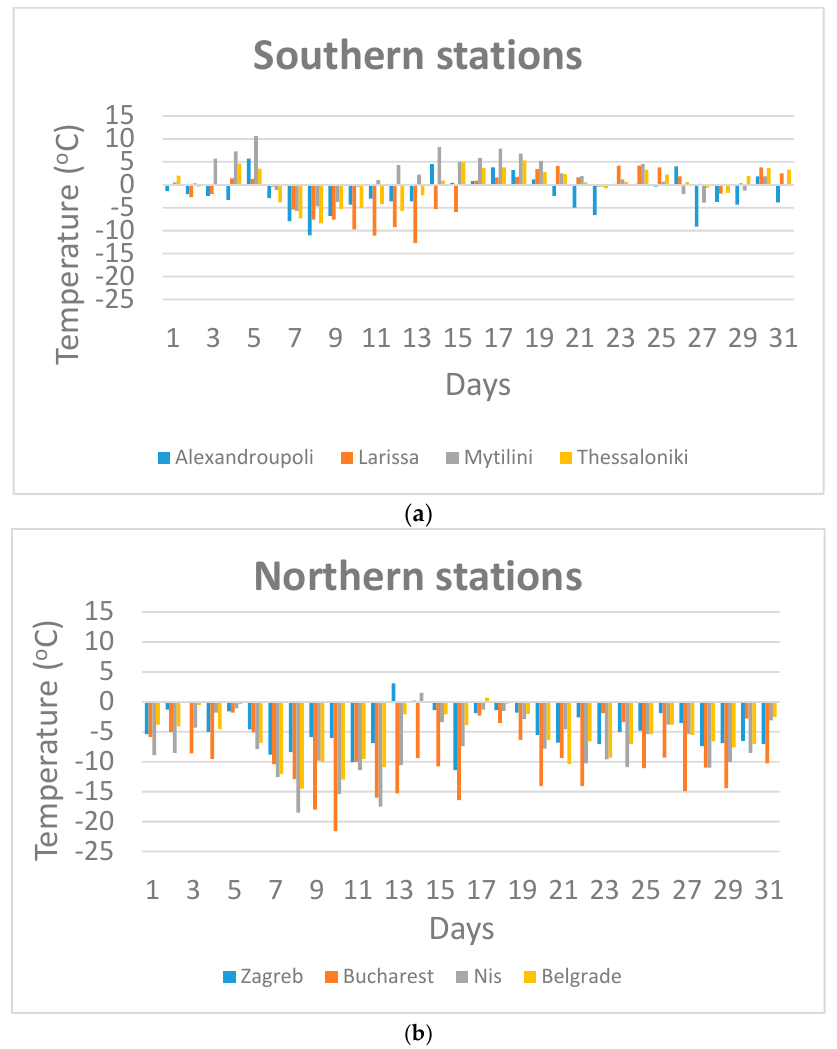
Figure 2. The minimum temperature variability of January 2017 for the ( a ) the southern stations and ( b ) the northern stations.